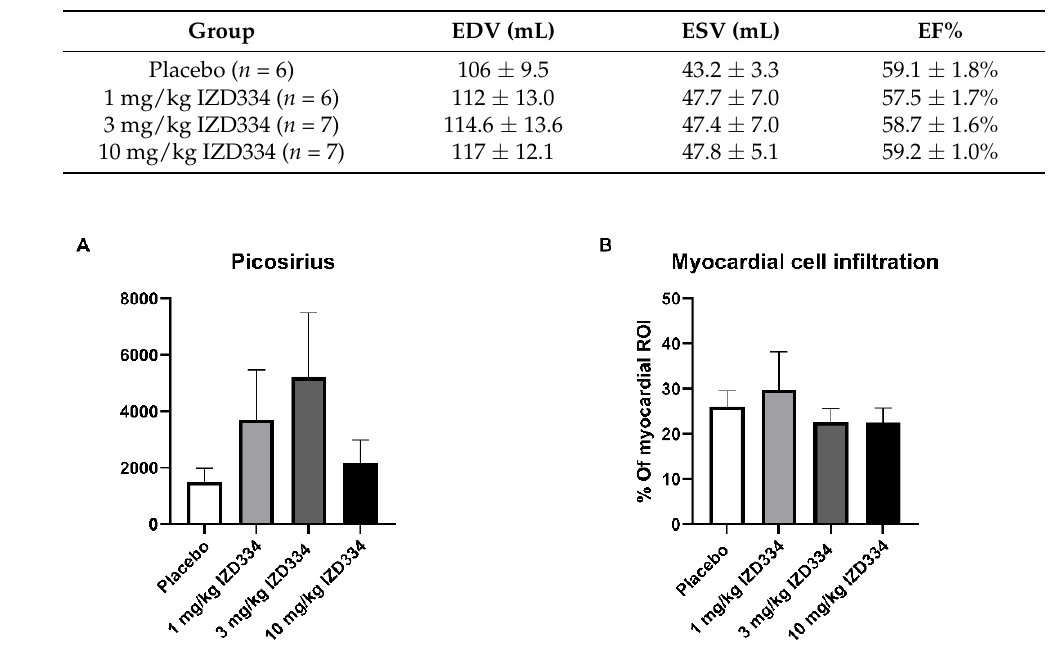
Table A4. Left ventricular volumes and ejection fraction (EF) measured with echocardiography at baseline. Abbreviations: EDV, end-diastolic volume; ESV, end systolic volume; EF, ejection fraction.